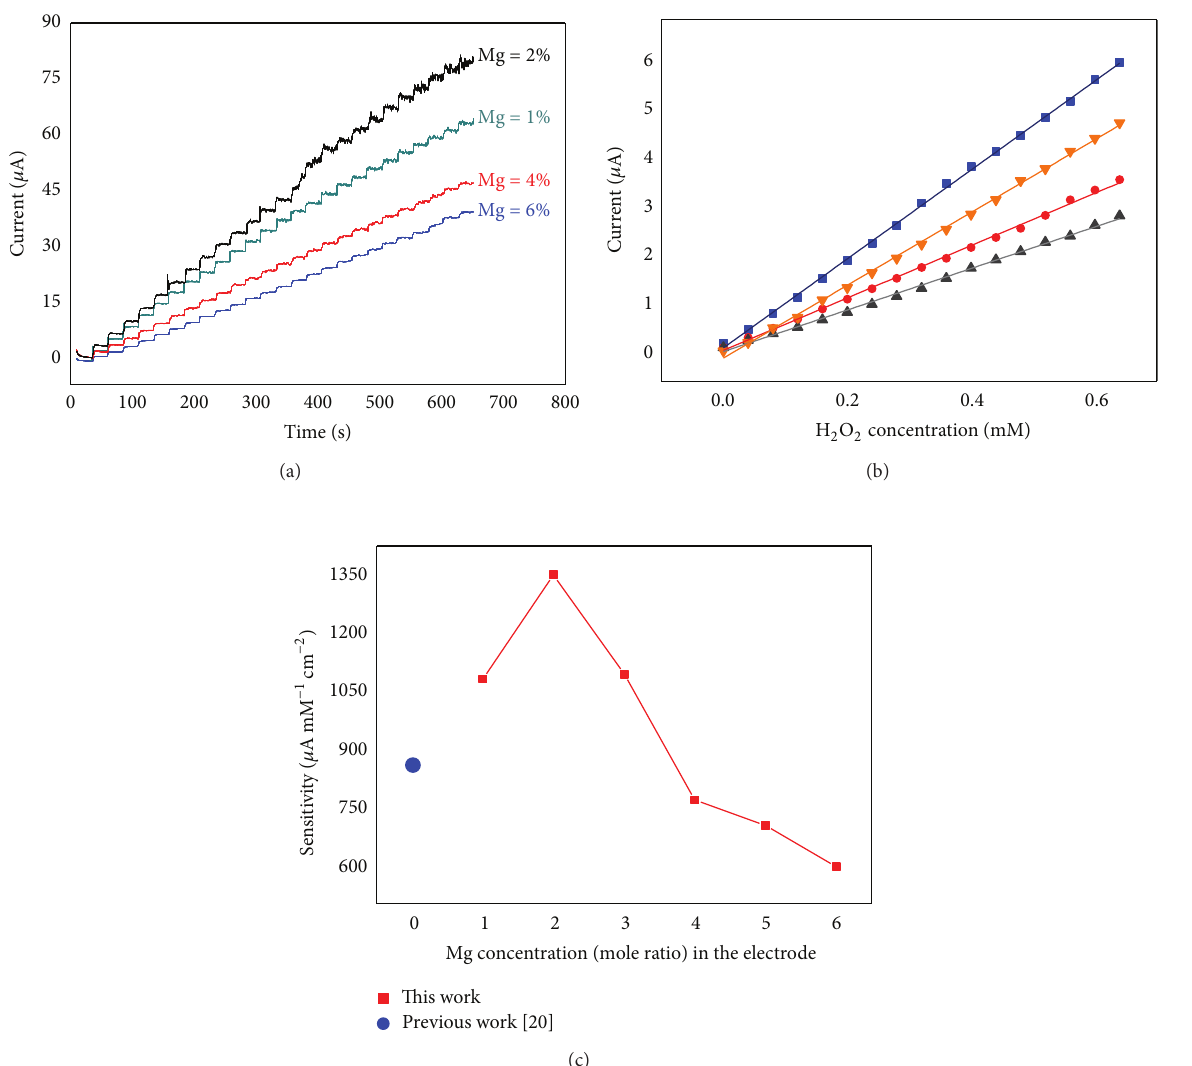
Figure 6: (a) Typical amperometric technique ( 𝐼 - 𝑡 ) curve of different modified electrodes (with different Mg concentrations (mole ratio): 1%, 2%, 4%, and 6%) after adding H 2 O 2 in stirred solution of 0.1 M PBS; (b) calibration plot of response current versus H 2 O 2 concentration of different modified electrodes (with different Mg concentrations (mole ratio); 1%, 2%, 4%, and 6%); (c) the sensitivity of different